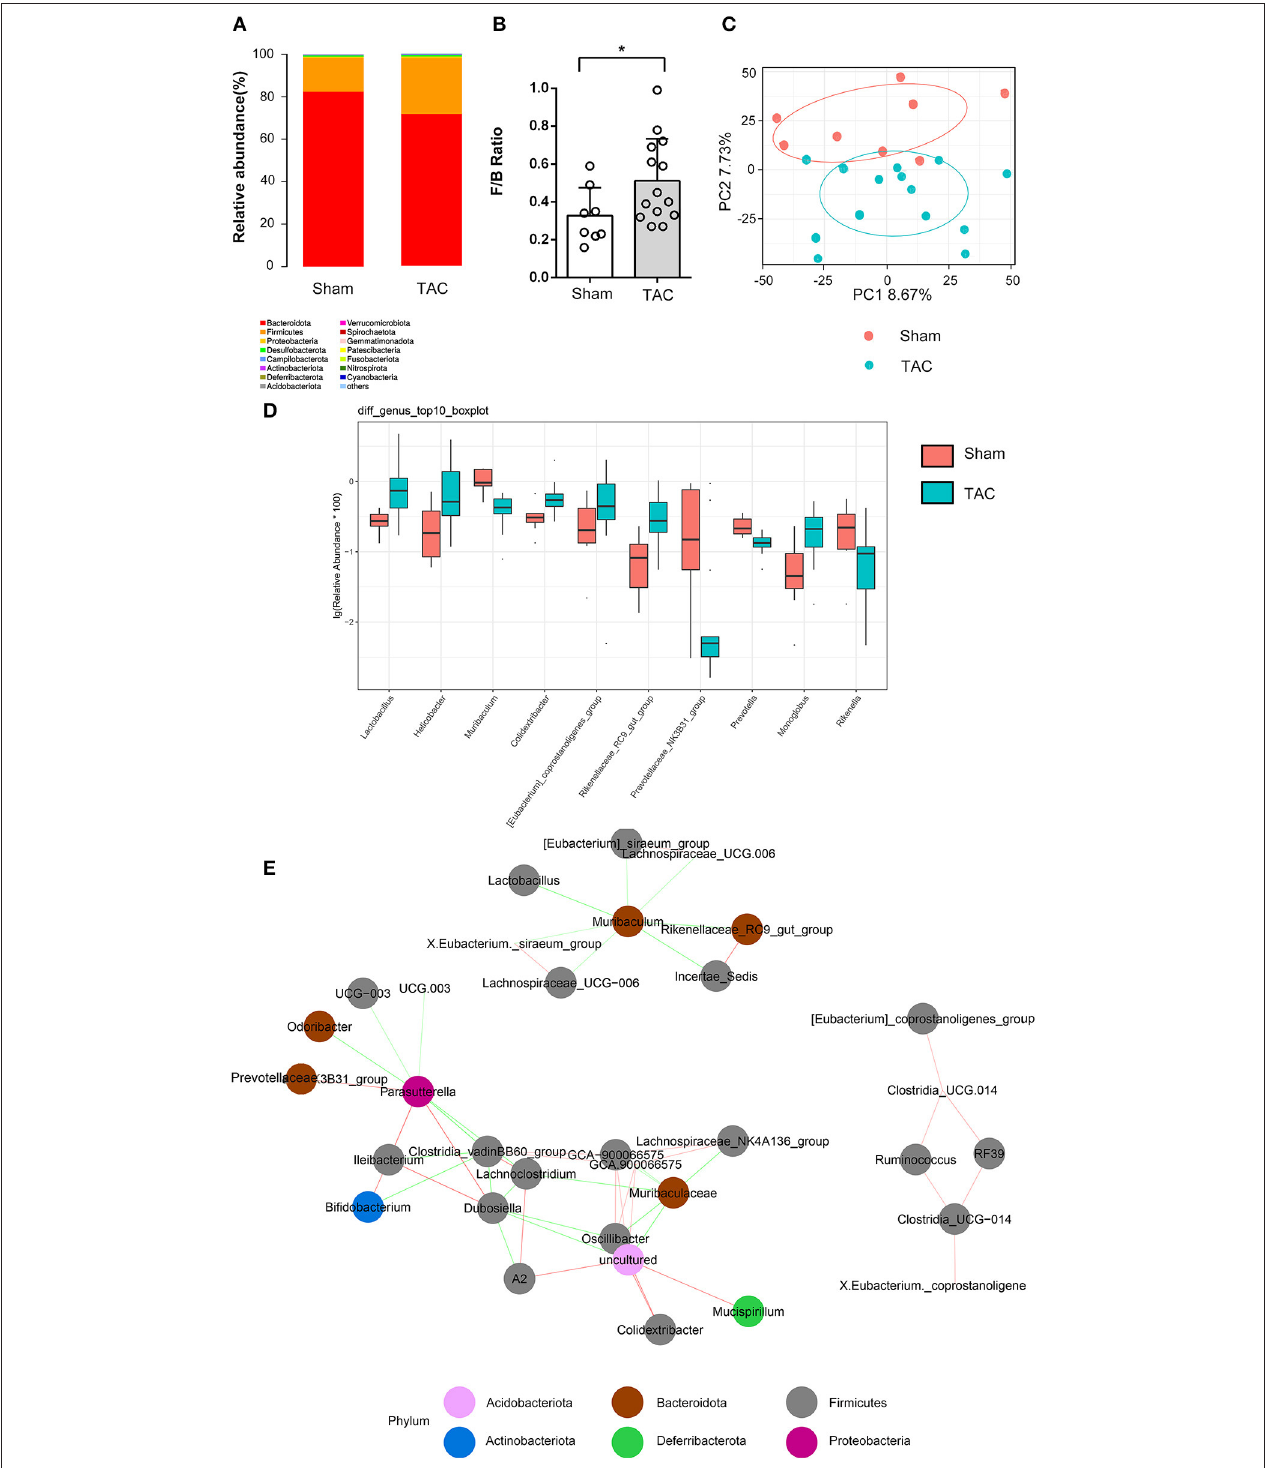
FIGURE 4 | Thoracic aortic constriction (TAC) surgery altered the gut microbiota, as measured by 16S rRNA sequencing. (A) Microbiota constituents are reflected by the relative abundances of microbiota. (B) F/B ratio of the TAC and sham groups at the phylum level. (C) Principal component analysis (PCA) of β diversity analysis based on Bray-Curtis distances. (D) The top 10 significantly differentially abundant genera in the two groups. (E) The coabundance relationships between the differential microbiota. The color of the connecting line indicates positive and negative correlation, where red indicates a positive correlation and green indicates a negative correlation. The shade of the color represents the strength of the correlation. Circles with different colors represent different taxonomies at the phylum level.